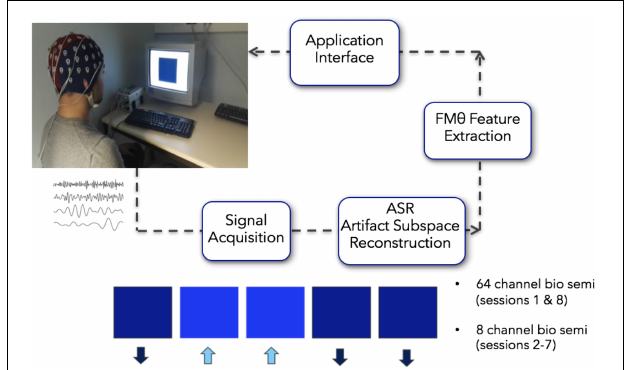
FIGURE 2 | Closed loop Neurofeedback protocol starting from the acquisition of the signal to the automated ASR artifact rejection, to the FM θ extraction to the interface. When recording more than 8 channels (first and last sessions recorded 64 channels), the 8 channels Fpz, FZ, F7, F8, Cz, P7, P8, Oz were extracted from the data – although only these 8 channels were collected on all recording days, on the first day and last recording day 64 channels were recorded. Images in this figure were obtained with written